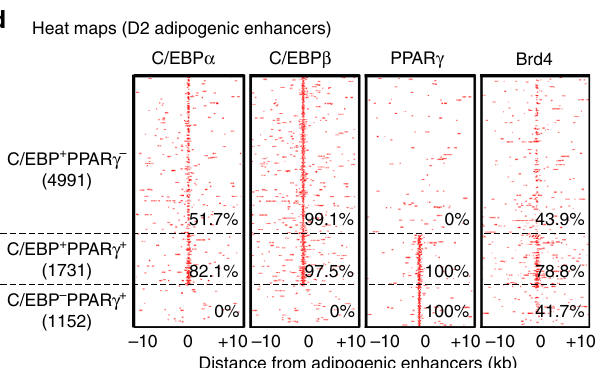
Fig. 5 Brd4 co-localizes with LDTFs on active enhancers during adipogenesis. a De fi nition of regulatory elements by histone marks. b Pie charts depicting the genomic distributions of Brd4 binding regions during adipogenesis. c Average binding pro fi les of Brd4 around the center of adipogenic enhancers and promoters. Adipogenic enhancers were de fi ned as active enhancers bound with C/EBP α , C/EBP β , or PPAR γ at D2 of adipogenesis as described previously 19 . Adipogenic promoters were de fi ned as promoters that are closest to adipogenic enhancers. d Brd4 co-localizes with LDTFs on active enhancers during adipogenesis. The binding pro fi les of C/EBP α , C/EBP β , PPAR γ , and Brd4 on the three types of